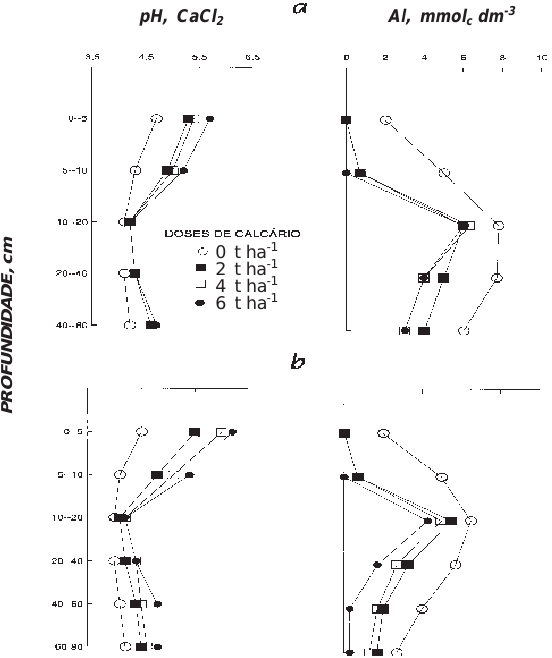
repetições.Figura 1. Efeito de doses de calcário nos valores de pH e teores de Al trocável do solo, em diferentes profundidades, após 12(a) e 28(b) meses da aplicação na superfície do solo. Média de 3